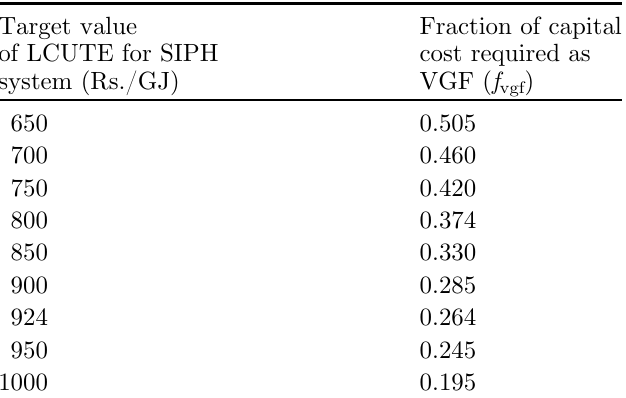
Table 2. VGF required (as a fraction of capital cost for different values of